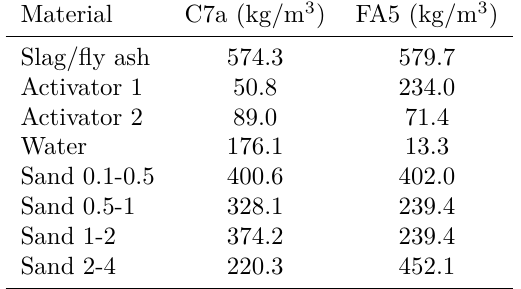
Table 1. Mortar composition.